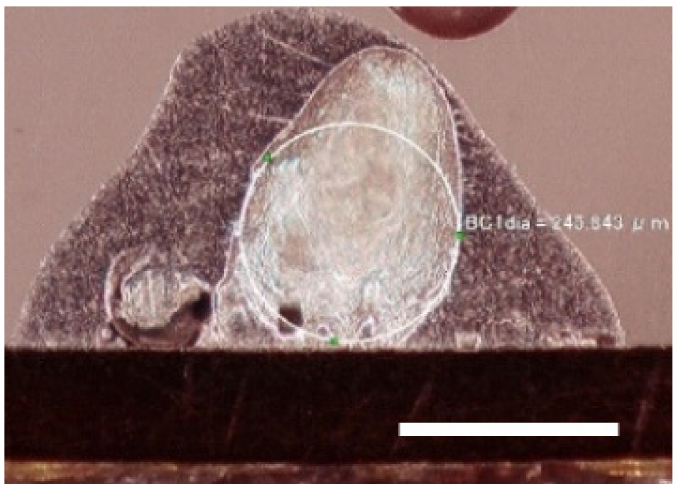
Figure 9. Approximate 245 µ m diameter of a pinhole being measured on a Hirox microscope. Scale bar = 250 µ